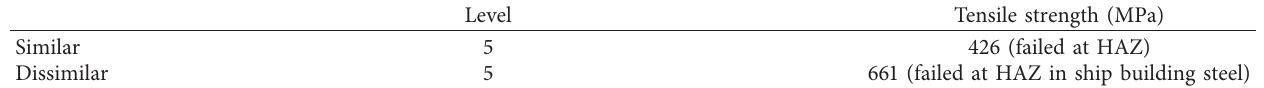
Table 22: Tensile and impact strength for dissimilar double V 45 °